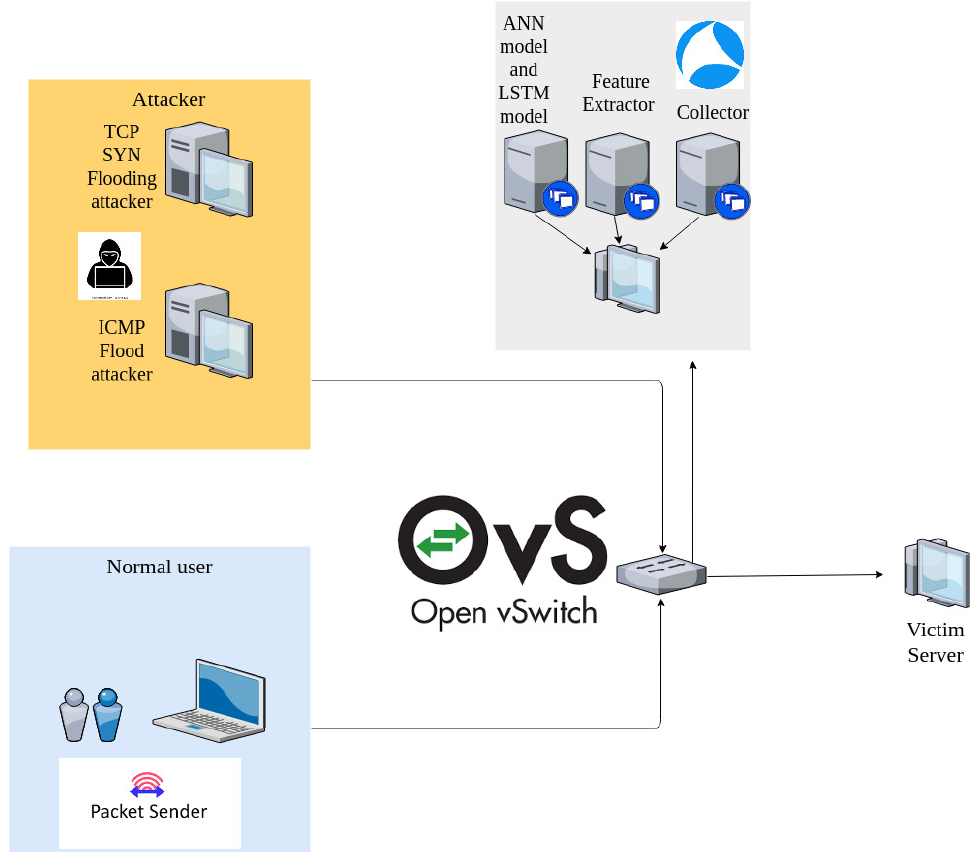
Figure 7. Experimental